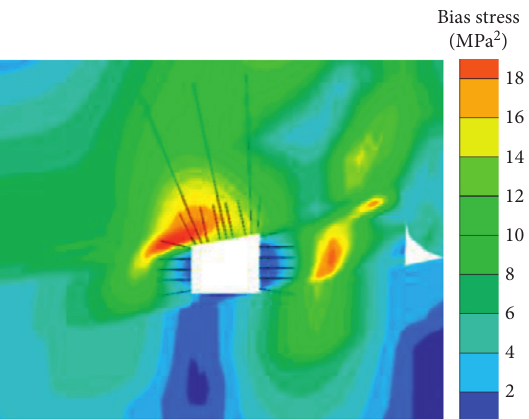
Figure 12: Cloud diagram of the second invariant of deviatoric stress distribution for the effect of rock support in the roadway.